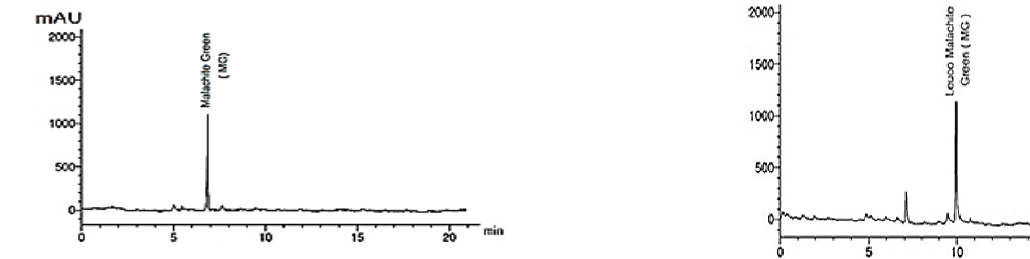
Figure 10. Cytotoxicity of MG and MG biodegraded products by S. exfoliatus strain on normal HSF cells maintained in DMEM media supplemented with 100 mg/mL of streptomycin, 100 units/mL of penicillin and 10% of heat-inactivated fetal bovine serum in humidified 5% ( v / v ) CO 2 atmosphere incubated at 37 ◦ C. ( A ) control treatment illustrates normal adherent cells. ( B ) cytotoxicity of MG by products show 96% viability at 200 µ g/mL with few damaged cells illustrated by a reduction in cell adhesion.